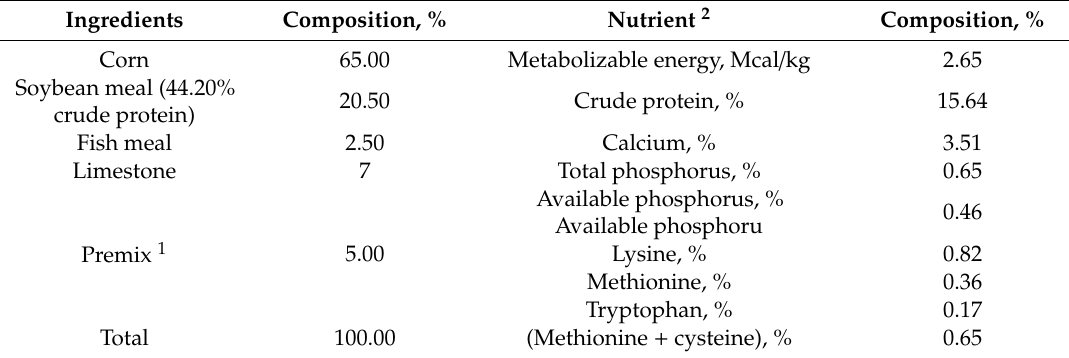
Table 1. Ingredient and nutrient composition of the basal diet (air-dry basis).